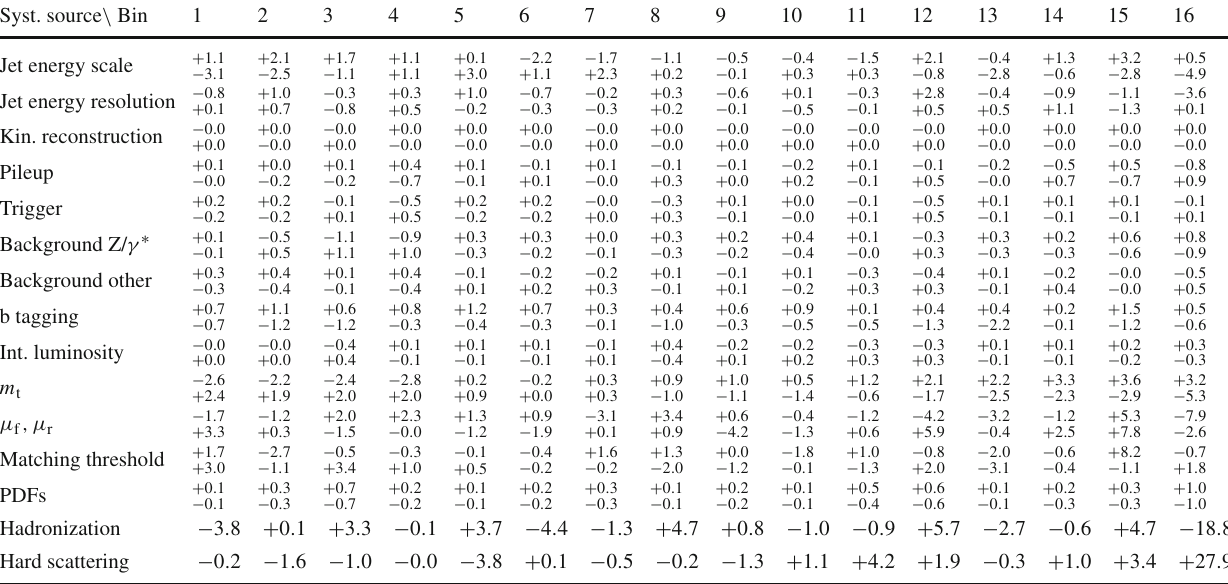
Table 13 Sources and values of the relative systematic uncertainties in percent of the measured normalized tt double-differential cross sections as a function of M ( tt ) and y ( tt ) . For bin indices see Table 11